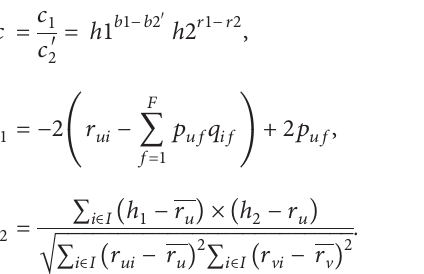
Figure 2: No coding perception.